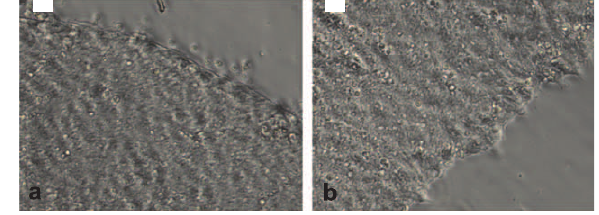
Figure 2. Microphotographs of HCMV-infected (a) and mock infected iPS cells. Scale bar is 50 m